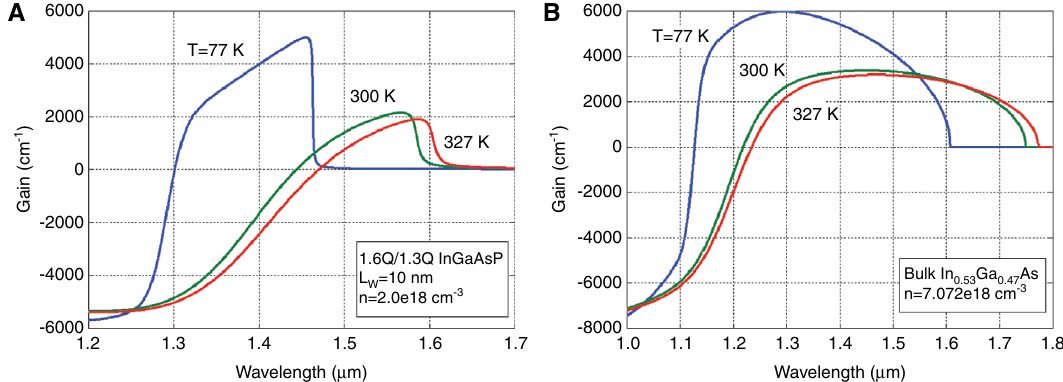
Figure 1 Material gain spectra with temperature as a parameter for (A) 10 nm 1.6Q/1.3Q InGaAsP QW near the transparent carrier density and (B) bulk In Ga As near the threshold carrier 0.53 0.47